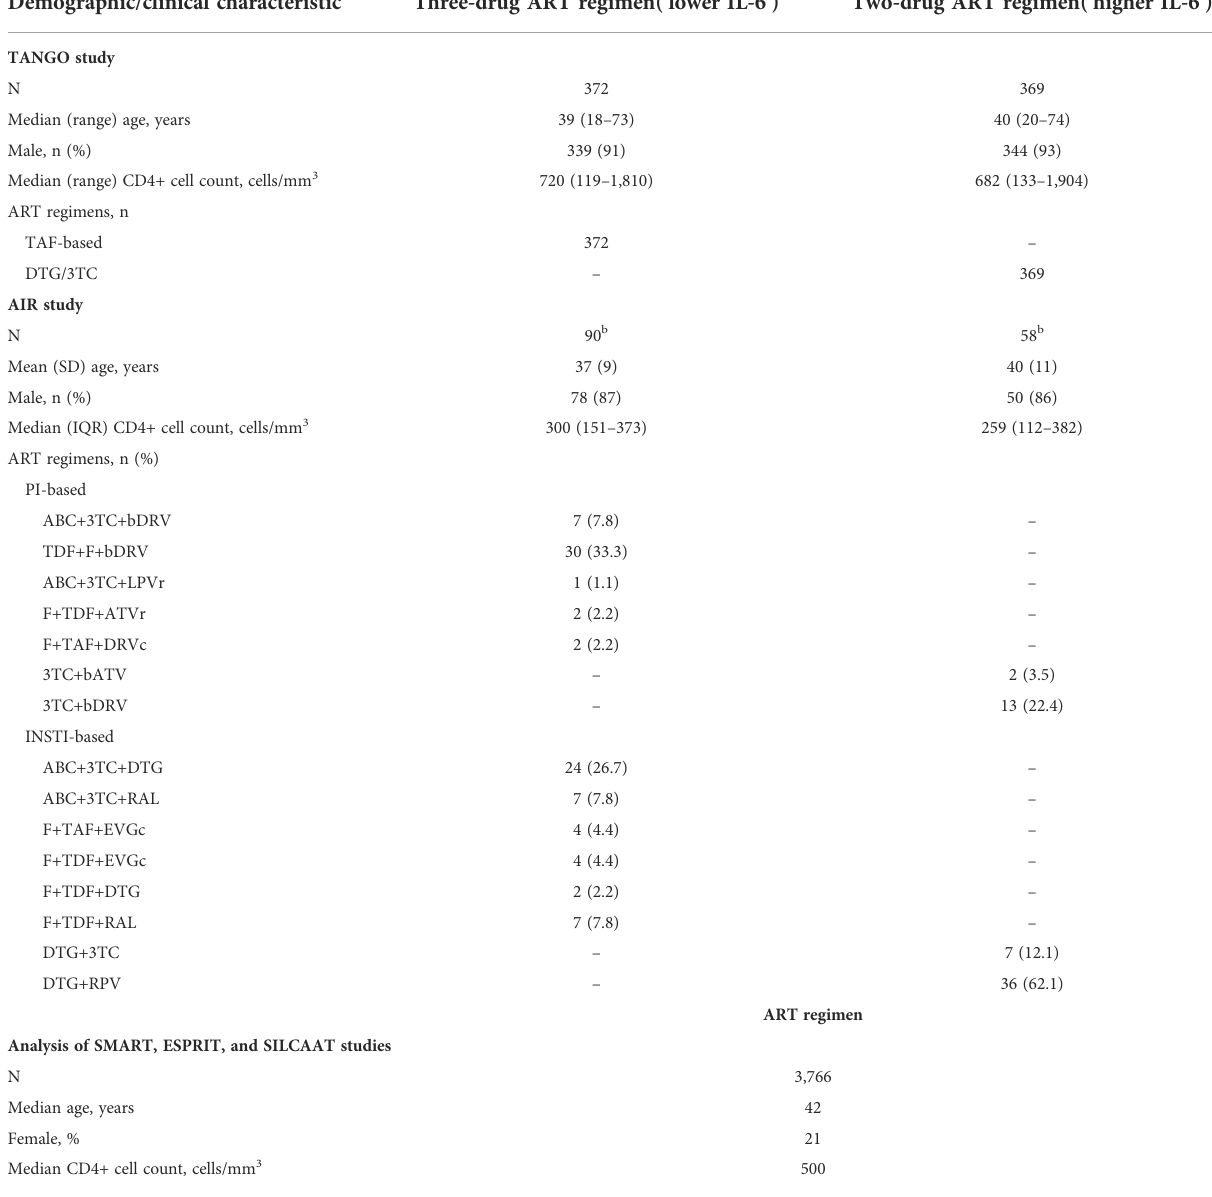
TABLE 1 Baseline demographics and clinical characteristics of the source data cohorts a (8, 20,